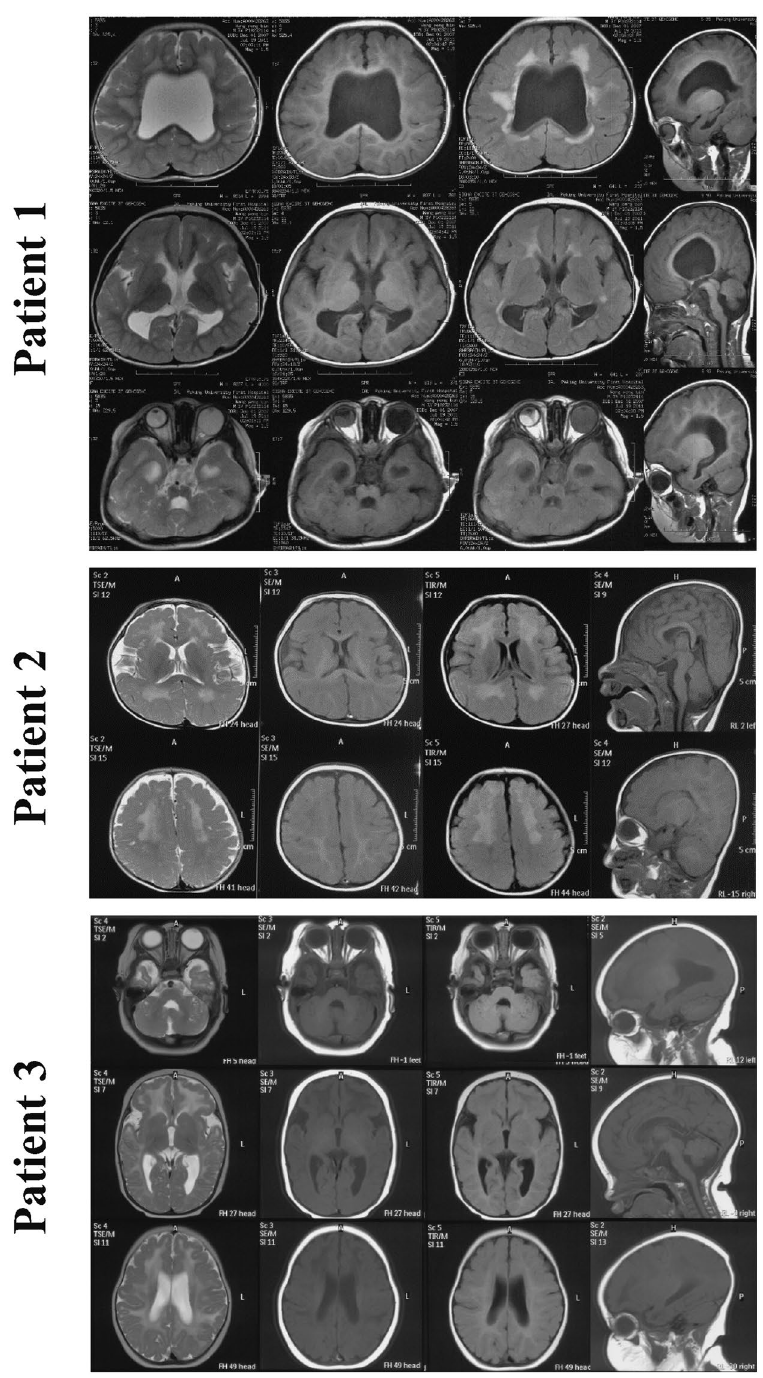
Figure 2. Brain MRI of all three patients. Patient 1 underwent a brain MRI at 3 years and 6 months of age, and showed micropolygyria, septum pellucidum absence, corpus callosum dysplasia, cerebellum hypoplasia, and cerebellar cysts with abnormal white matter signals in T1W and T2W. A brain MRI of patient 1 also showed right microphthalmus, amotio retinae, and left eye irregular shape. Patient 2 underwent a brain MRI at 8 months of age and demonstrated frontal lobe micropolygyria, increased white matter signals in T2W and fluid attenuated inversion recovery (FLAIR), and dysplasia of the brainstem and cerebellum. Patient 3 underwent a brain MRI at 4 months of age, and showed frontal lobe micropolygyria, abnormal white-matter signals in the bilateral frontal region, dysplasia of the brainstem and cerebellum, and cerebellar cysts with abnormal white matter signals in T1W, T2W and